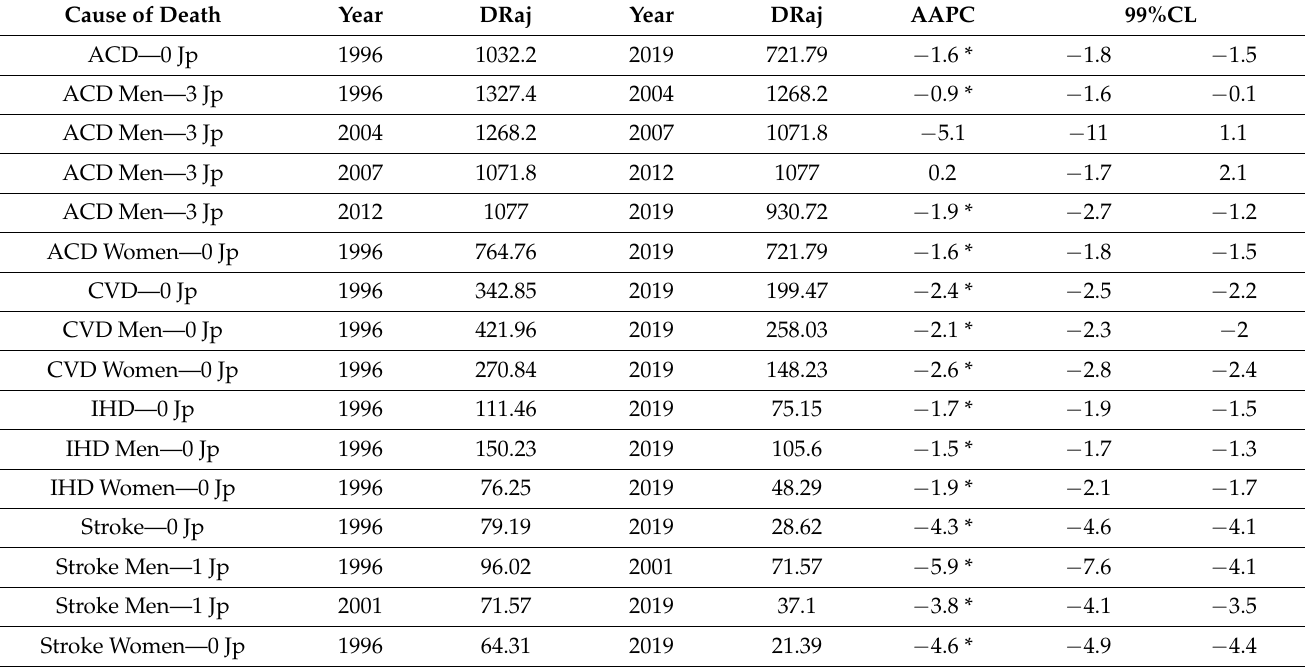
Table 1. Adjusted death rates (DRaj) per 100,000 population for the age group 35 to 74 years, the number of Jp, and the mean annual percentage change (AAPC) for all causes of death (ACD), cardiovascular disease (CVD), ischemic heart disease (IHD) and stroke in men and women from 1996 to 2019. Cause of Death Year DRaj Year DRaj